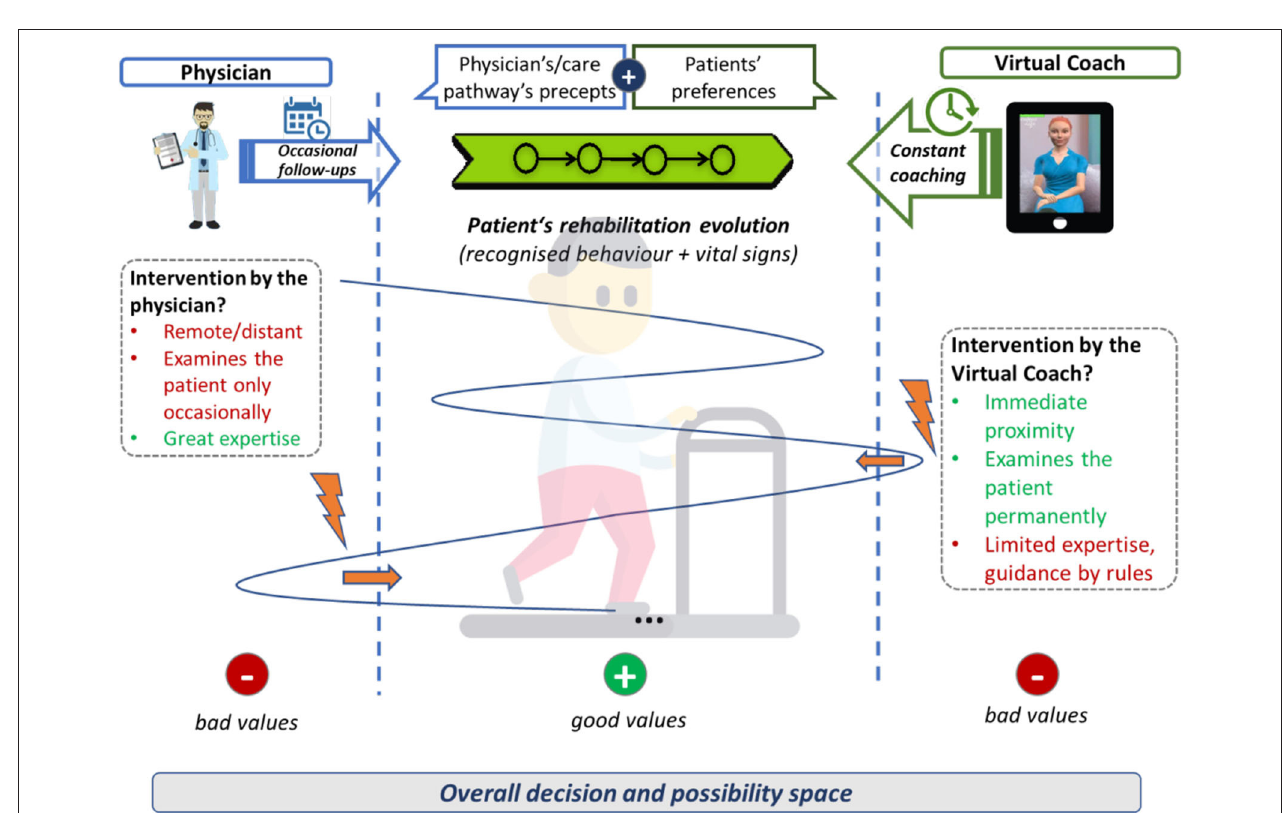
FIGURE 4 | Decision and possibility space and respective possible interventions.